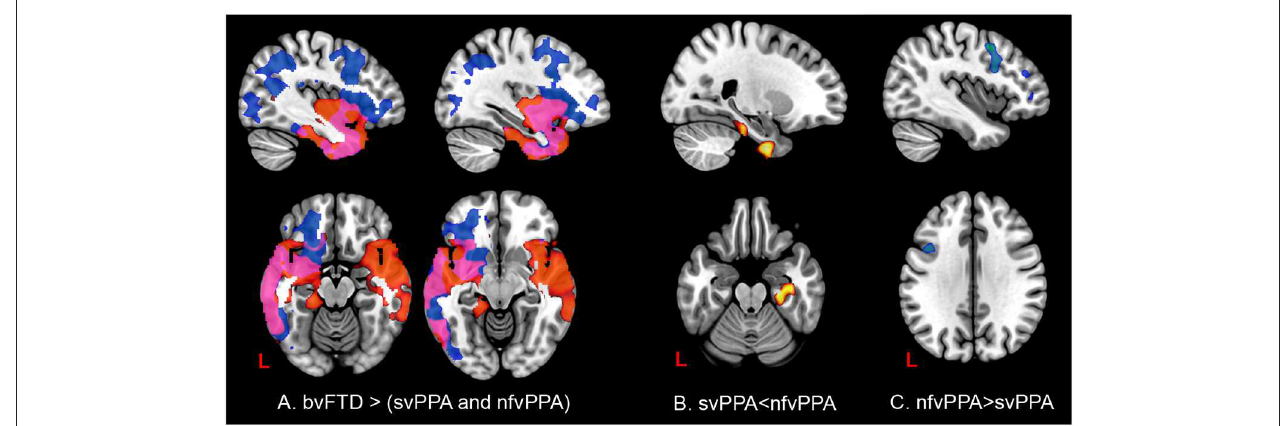
FIGURE 7 | Comparisons of gray matter between behavioral variants and primary progressive variants. Each tile shows significant regions (correction by threshold-free cluster enhancement, p < 0.05, permutations: 8000) VBM analysis. (A) Regions with atrophy at linguistic variants regarding bvFTD. Blue: gray matter with changes in nfvPPa; Red: gray matter with changes in svPPA; Pink: gray matter with changes in svPPA and nfvPPA. (B) Gray matter changes in svPPA regarding nfvPPA. (C) Gray matter changes in nfvPPA regarding svPPA. The table of main locations and their labels and coordinates can be found in Supplementary Data .